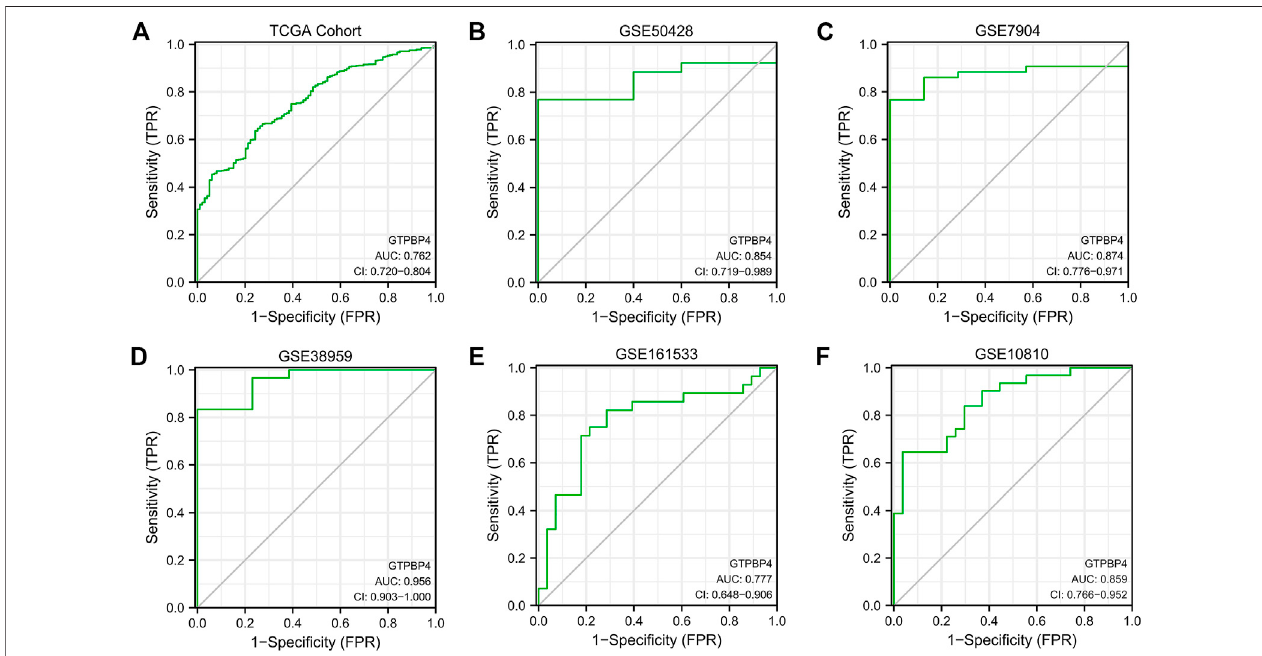
FIGURE 4 | The diagnostic accuracy of GTPBP4 was quanti fi ed by constructing a ROC curve and calculating the area under the curve. (A) ROC curve of TCGA cohort. The AUC value is 0.762. (B) ROC curve of GSE50428. The AUC value is 0.854. (C) ROC curve of GSE7904. The AUC value is 0.874. (D) ROC curve of GSE38959. The AUC value is 0.956. (E) ROC curve of GSE161533. The AUC value is 0.777. (F) ROC curve of GSE10810. The AUC value is 0.859.